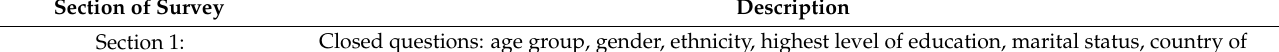
Table 1. Description of survey questions by section of